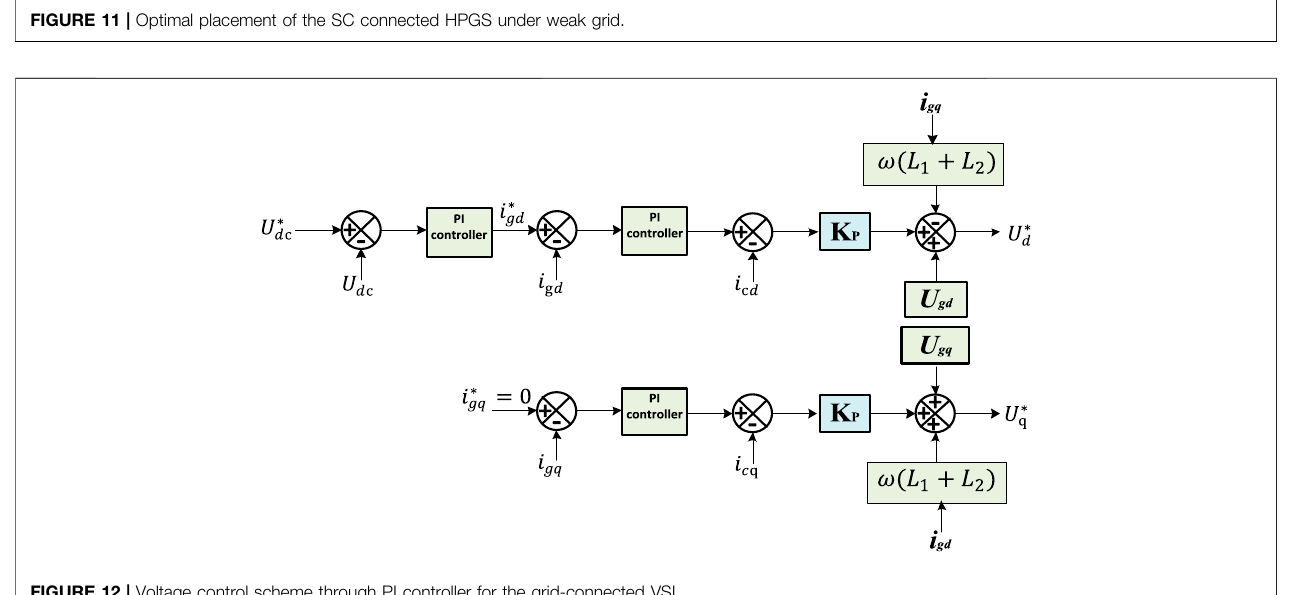
FIGURE 12 | Voltage control scheme through PI controller for the grid-connected